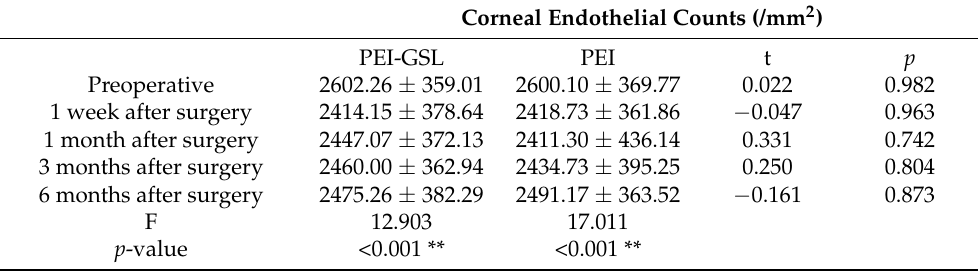
Table 3. Comparisons of corneal endothelial counts between PEI-GSL and PEI